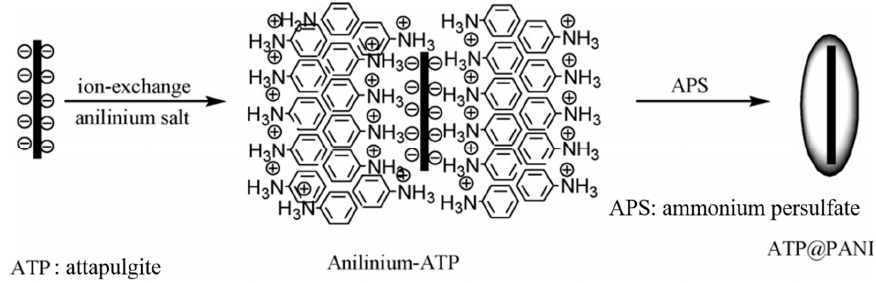
Scheme 3. The synthesis mechanism of the PANI coated clay, (take ATP as an example) ([75], © Elsevier, 2007).